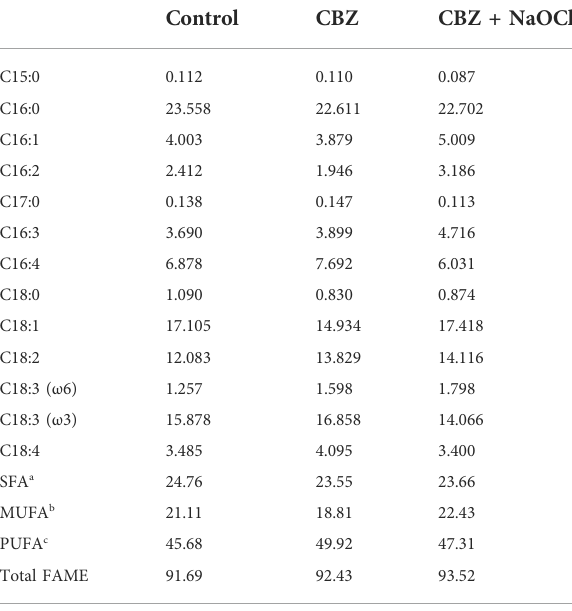
a Saturated fatty acid. b Monounsaturated fatty acid. c Polyunsaturated fatty acid.